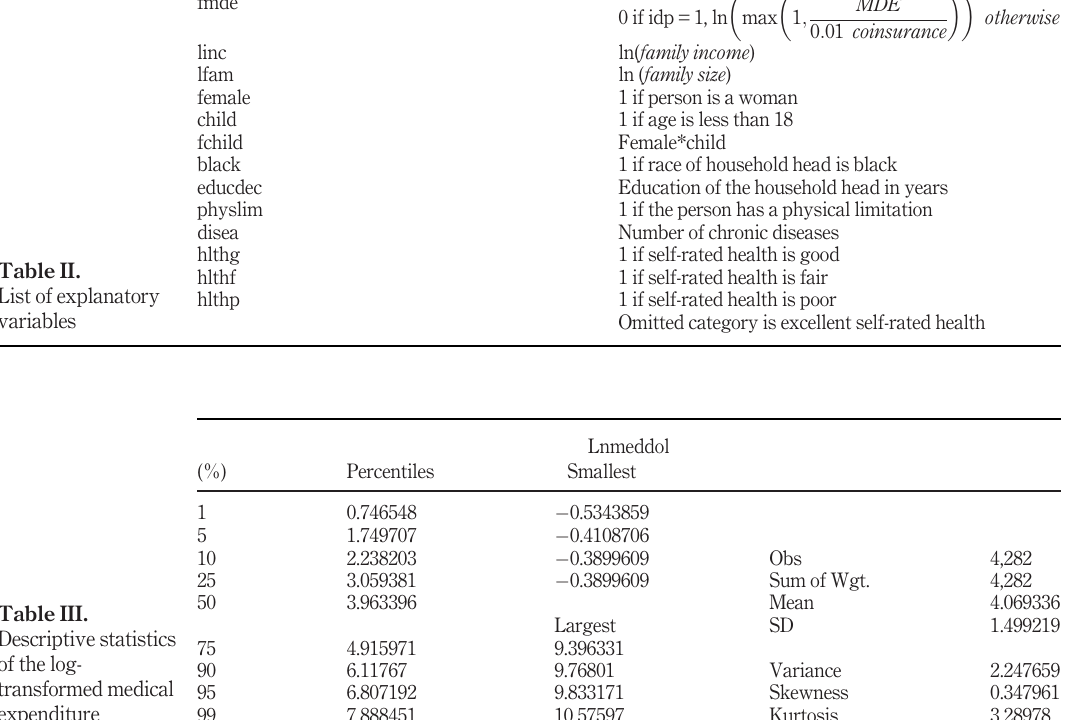
of the log- transformed medical